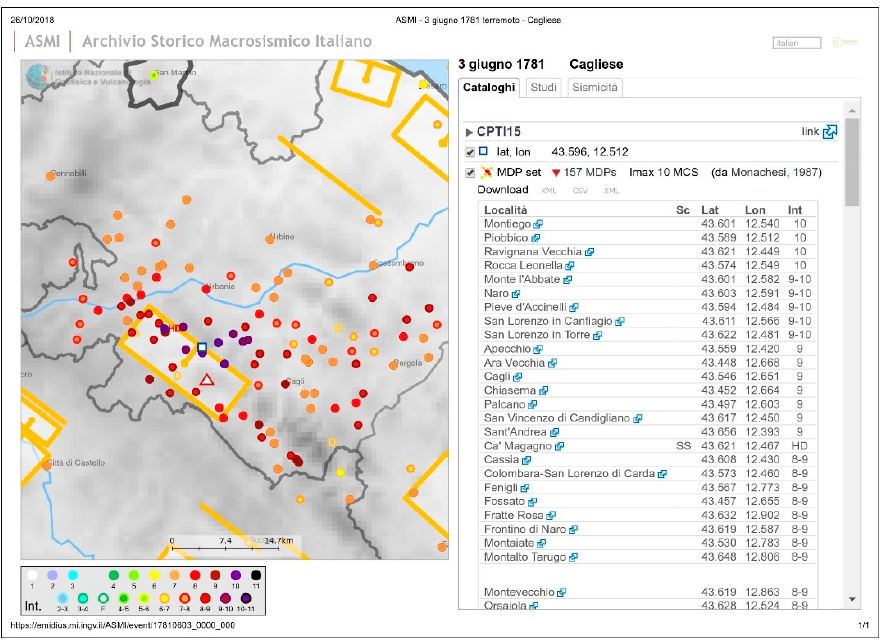
Figure 12. Record of 1781 Cagli earthquake from the Italian Historical Macroseismic Archive (ASMI) (https://emidius.mi.ingv.it/ASMI/index_en.htm).